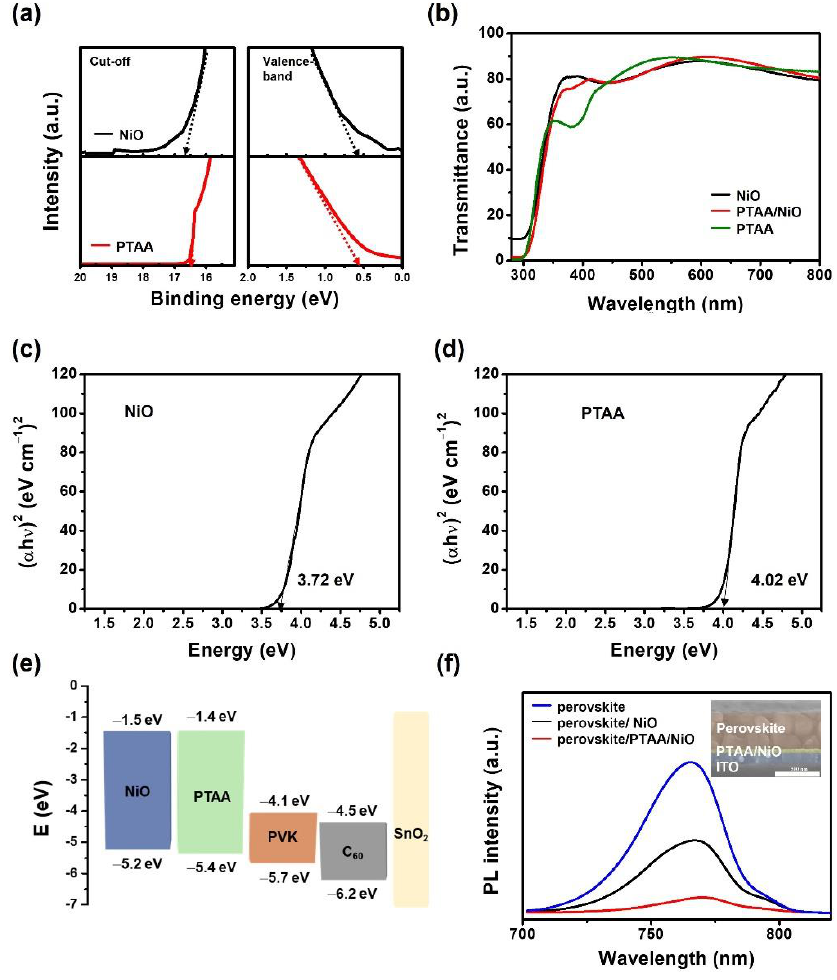
Figure 5. ( a ) UPS spectra for NiO and PTAA films. ( b ) UV – Vis transmittance spectra of various HTL films; NiO, PTAA, PTAA/NiO (bilayer) on ITO substrate. Tauc plot of ( c ) NiO film and ( d ) PTAA film. ( e ) Energy level diagram of the whole layer PSC device. ( f ) Steady-state PL spectra of perovskite, NiO/perovskite, and perovskite /PTAA/NiO films. Inset: the cross-view SEM image of perovskite/PTAA/NiO film.